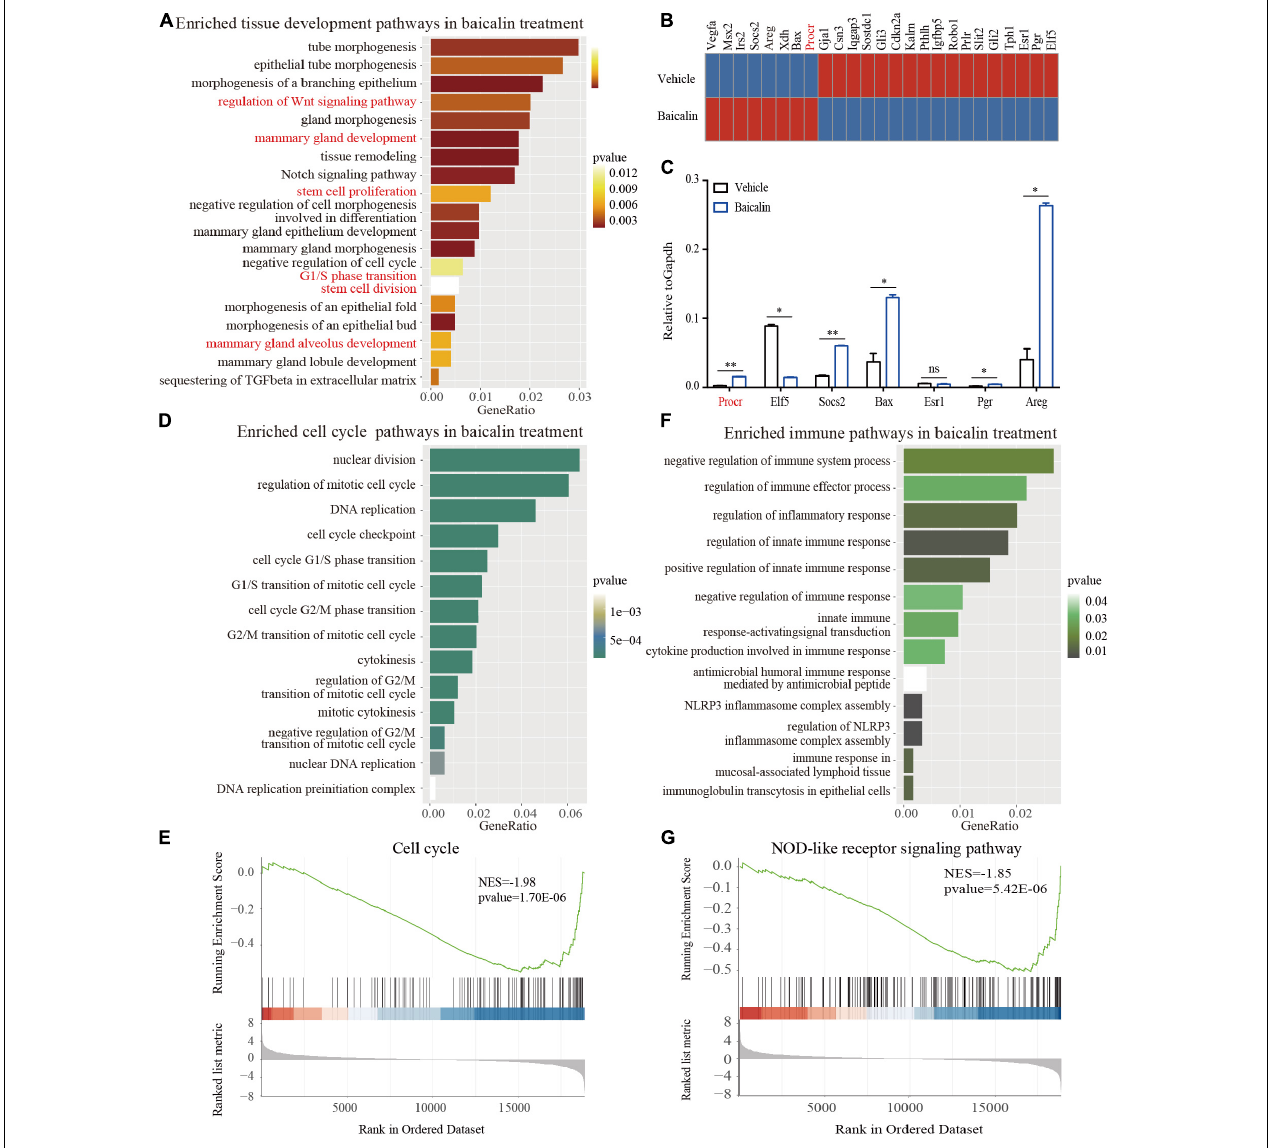
FIGURE 5 | Transcriptome analysis of basal cells treated with baicalin. (A) GO enrichment analysis of development-related pathways in 3D-cultured basal cells. (B) Heatmap analysis of genes related to mammary gland development differentially regulated in response to baicalin. (C) RT-qPCR analysis indicates that baicalin regulates genes related to mammary gland development. Student’s t -test: ** P < 0.01; * P < 0.05; ns, not significant. (D) GO enrichment analysis of cell division-related pathways in 3D-cultured basal cells. (E) GSEA (Gene Set Enrichment Analysis) revealed that cell cycle genes are down-regulated by baicalin. (F)